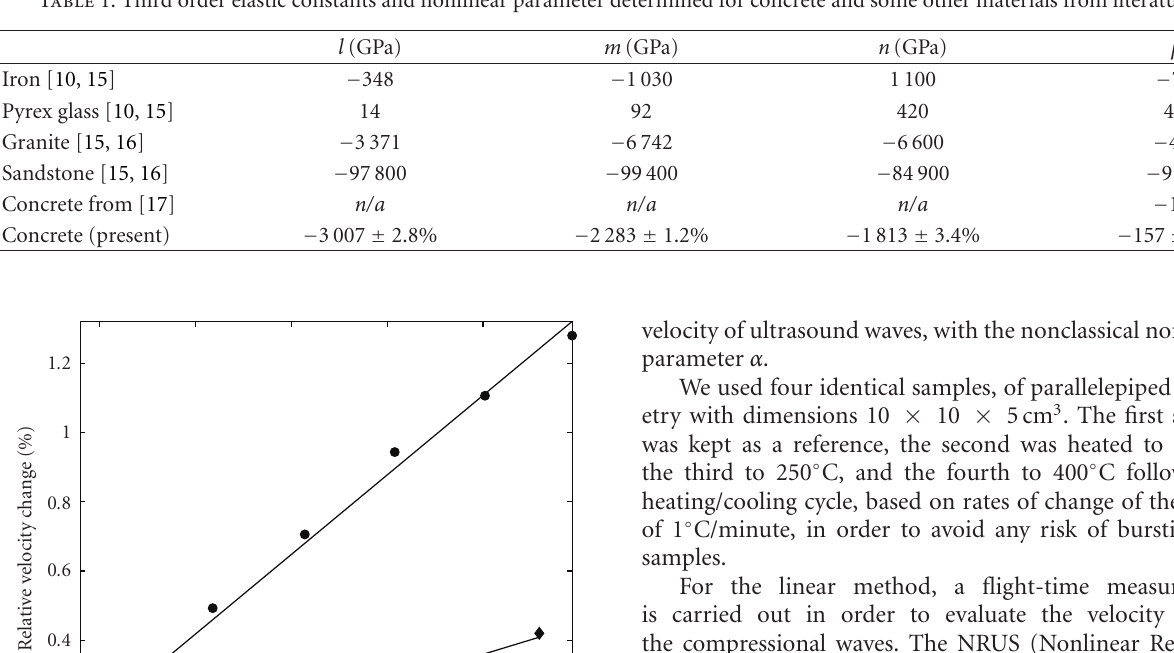
Figure 2: Experimental setup Table 1: Third order elastic constants and nonlinear parameter determined for concrete and some other materials from literature.